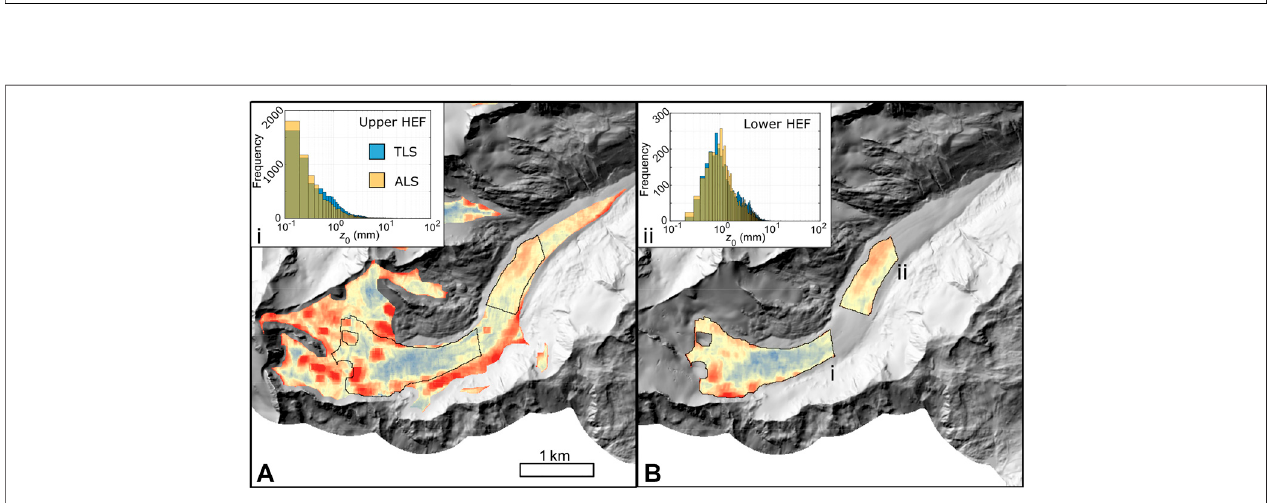
FIGURE6| Corrected z 0ALS forHEF (A) withTLSareaoverlain.Corrected z 0TLS shownin (B) .Comparisonofdistributionsforupper(i)andlower(ii)glaciershownin insets – ALS data in front of TLS data.